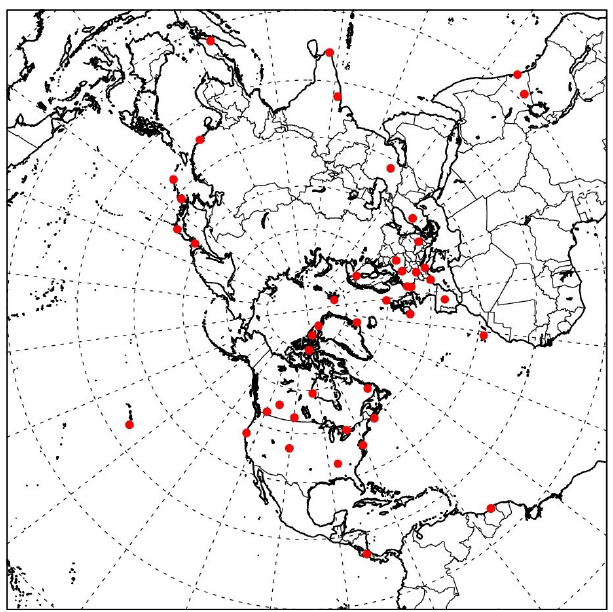
Figure 1. Simulation domain and spatial locations of the 44 WOUDC sites used in this